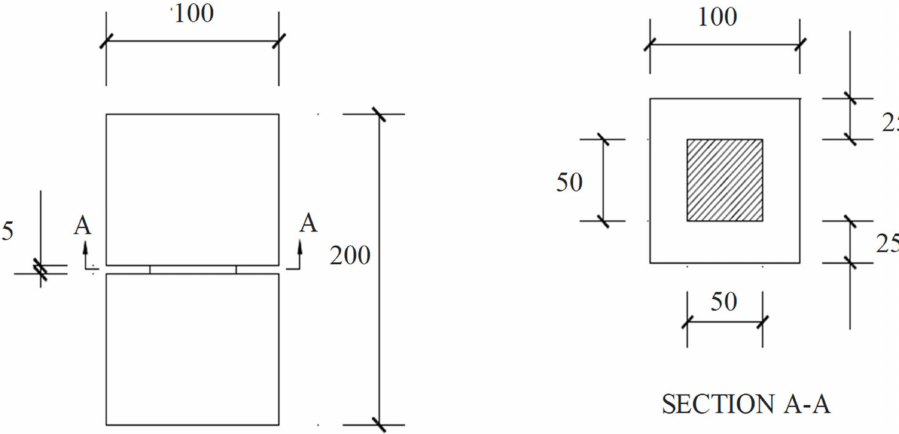
Figure 4. Prismatic notched specimens for direct tensile test (mm).